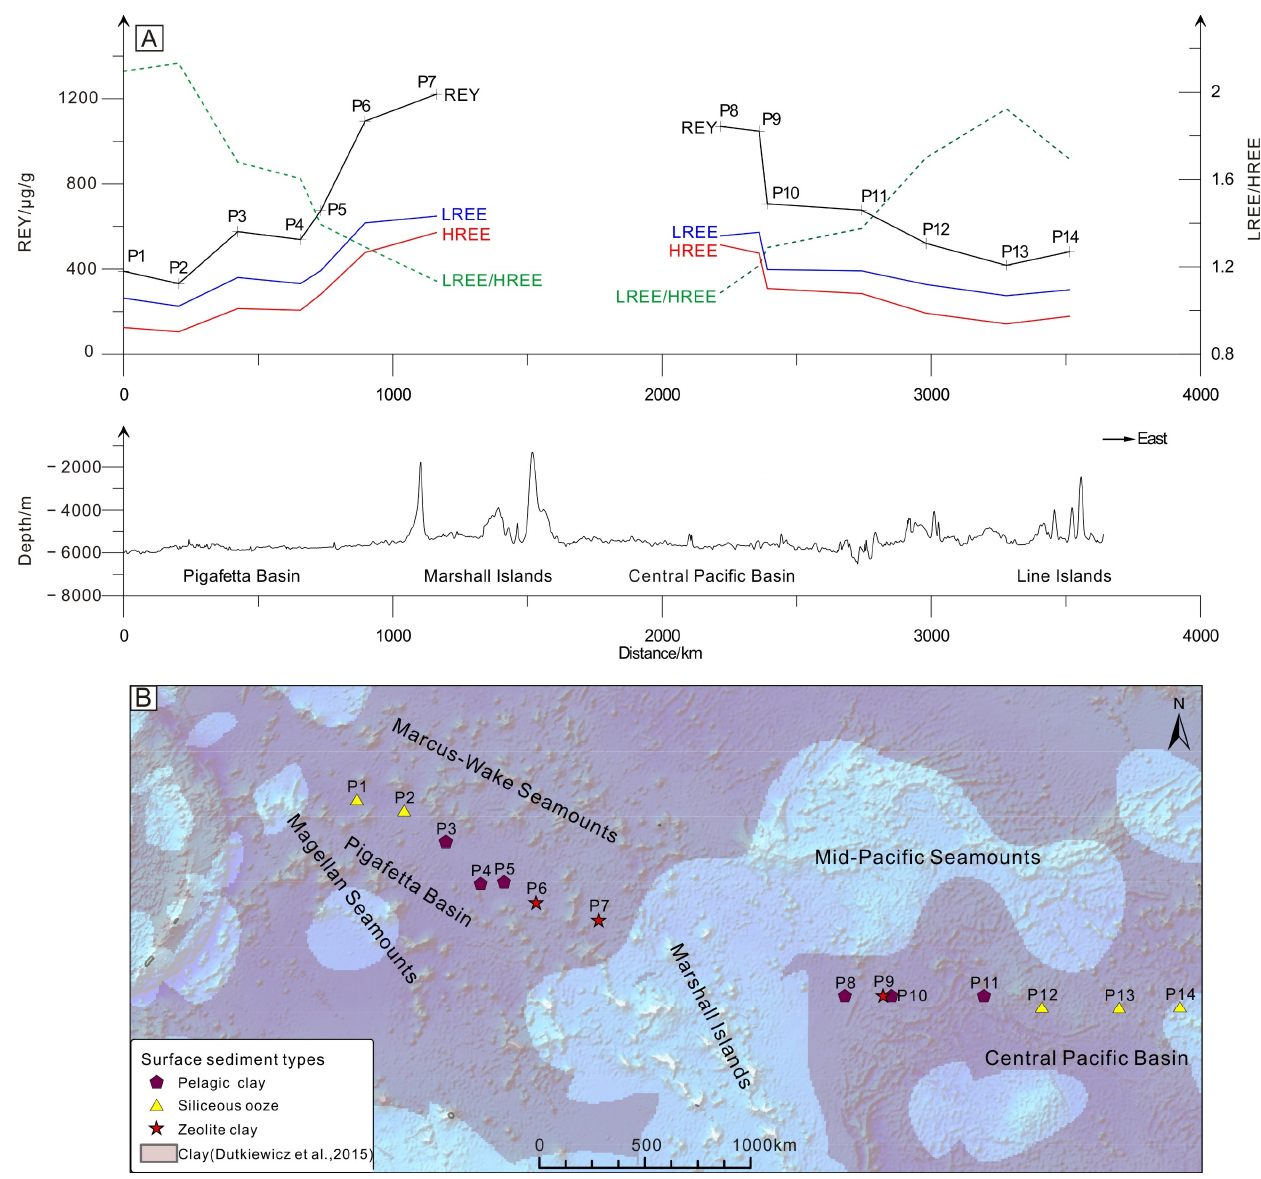
Figure 2. Characteristics of REY and sediment types in surface sediments (<2 m) in the Central and Western Pacific. ( A ) Characteristics of REY; ( B ) dominant surface sediment types (<2 m). P1–P14 correspond to piston cores. Table 1. Water depth and length of the 14 piston cores, with type and REY content of their surface sediments (<2 m) in the study